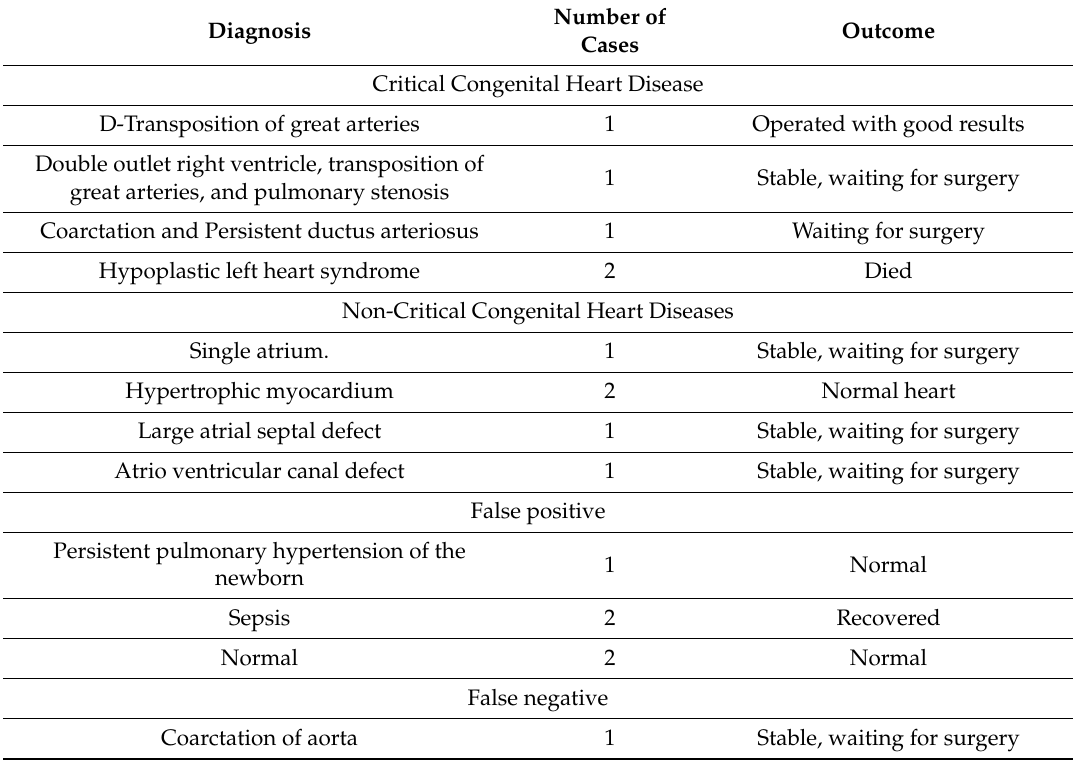
Table 1. Repartition of failing test